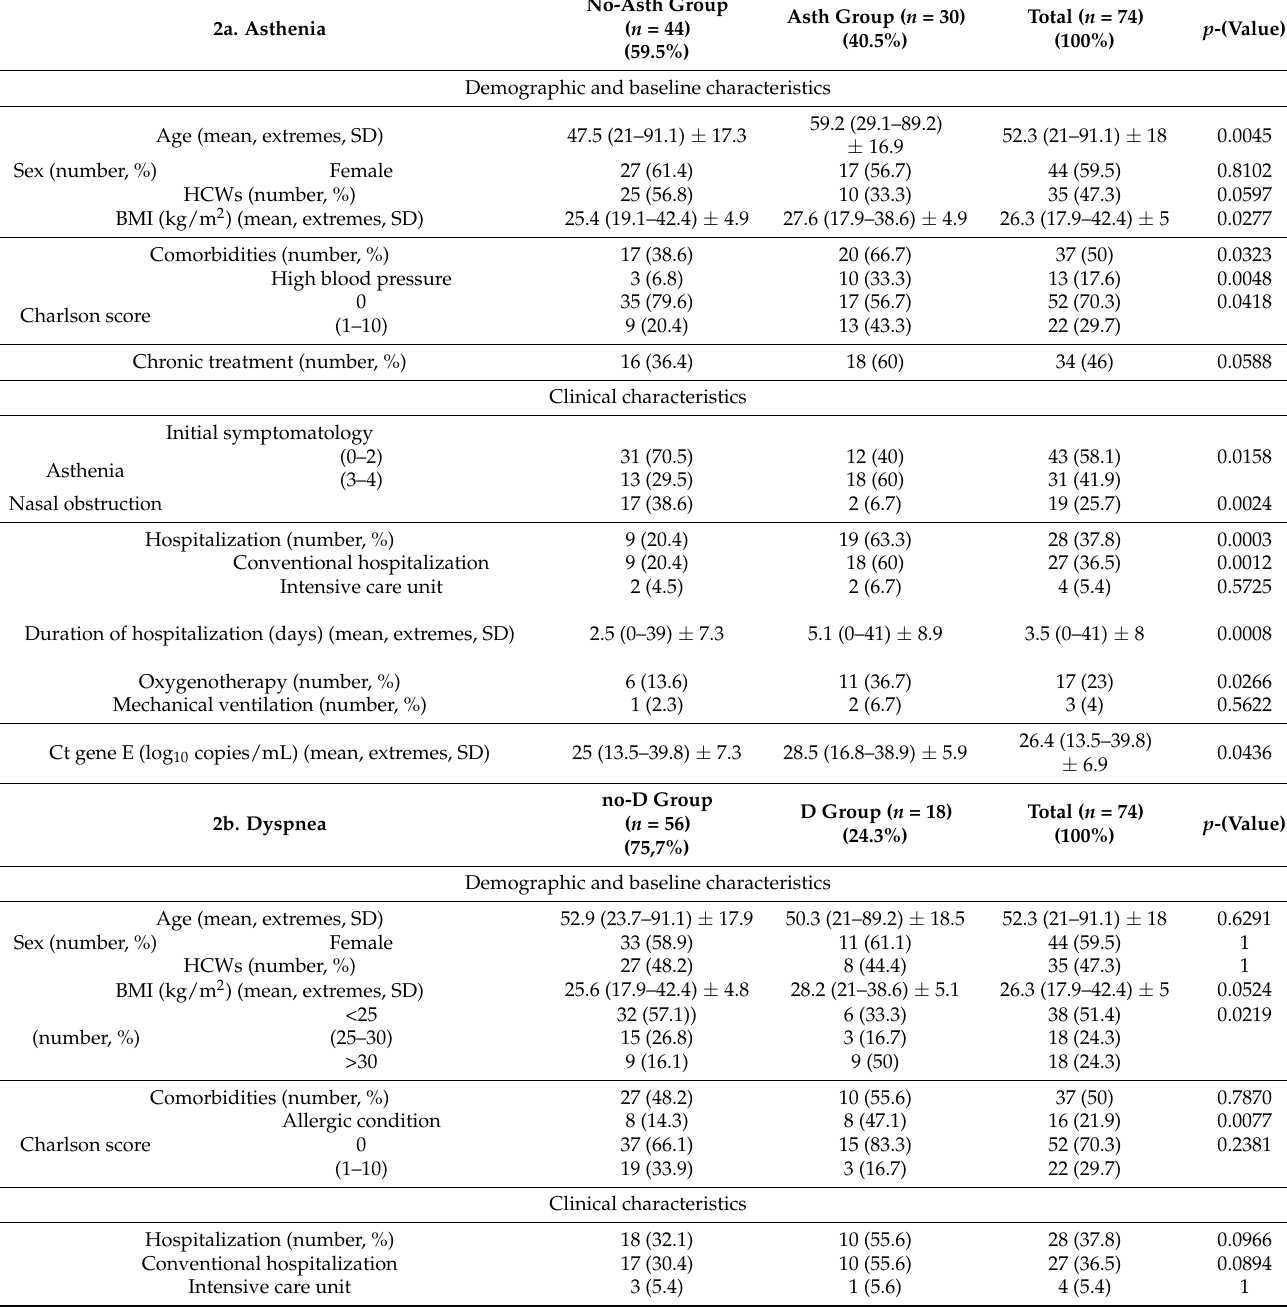
Table 2. Comparison of patients by most common persistent